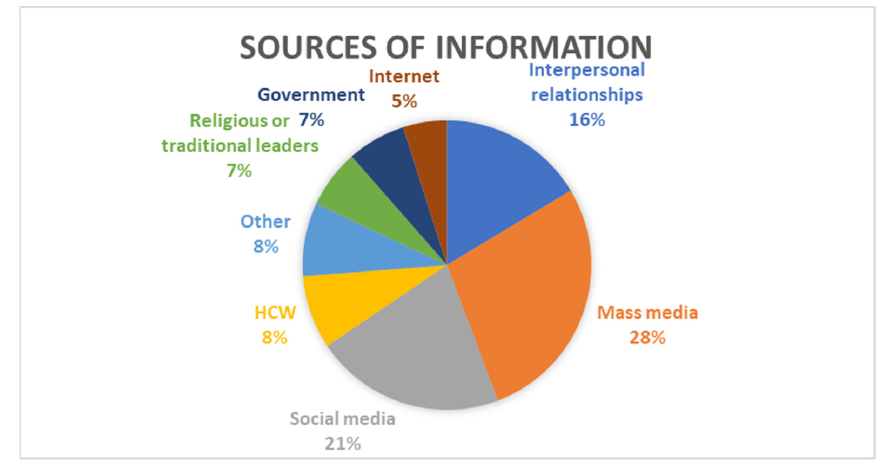
Figure 3. Information sources regarding COVID-19